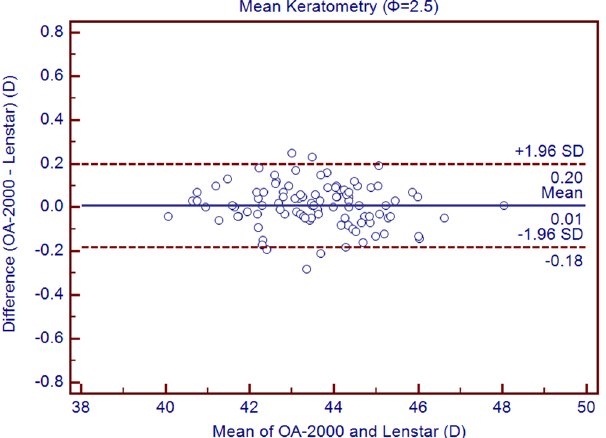
Figure 9. Bland-Altman plots show the agreement between OA-2000 swept-source optical coherence tomography and Lenstar optical low coherence reflectometry for measuring mean keratometry (Km) at 2.5 mm. Solid lines represent the bias between both devices and dotted lines represent the 95% confidence interval for the difference.